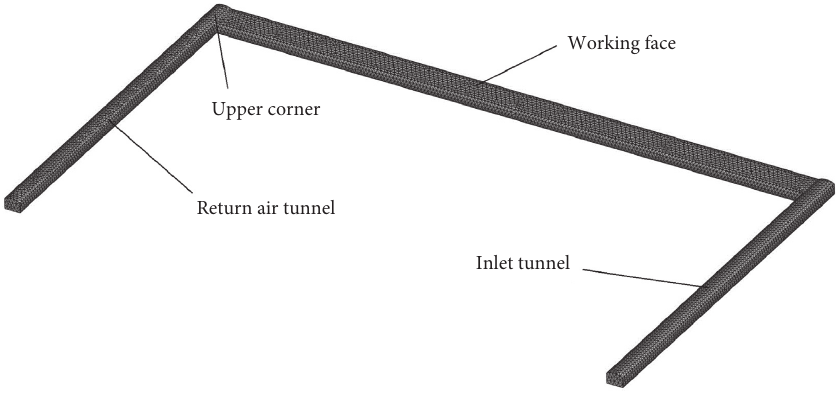
Figure 3: Three-dimensional physical